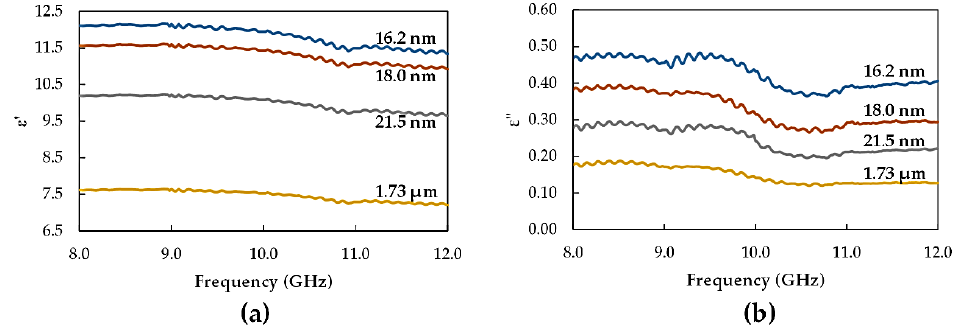
Figure 8. Variation of ( a ) ε' and ( b ) ε" with frequency for different recycled α -Fe 2 O 3 particle sizes.